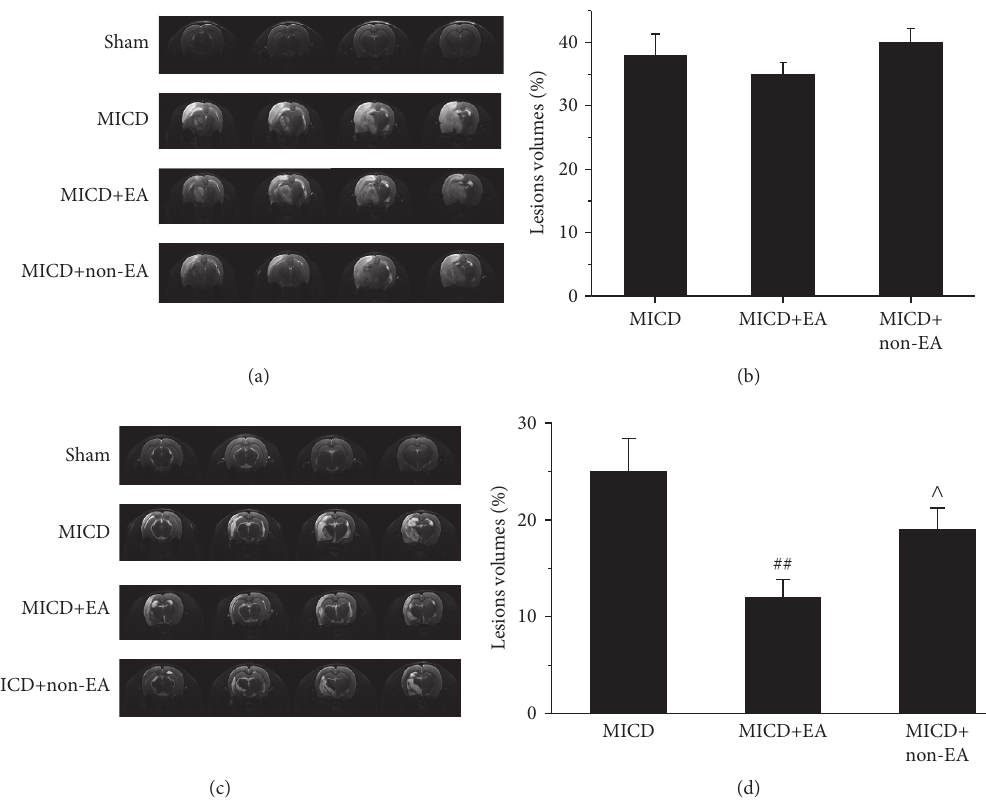
Figure3:T2WIsignalchangesbeforeandafterEA(aandc).ThebrainlesionsweremeasuredbyT2WI(slicesfrom11to13)intheShamgroup, the MICD group, the MICD+EA group, and the MICD+non-EA group before (a) and after (c) EA. (b and d) Lesion volume is represented as a percentage of the total brain volume and data are presented as the mean ± standard deviation from 12 individual rats in each group. ( ∗∗ 𝑝 < 0.01 versus the Sham group; ## 𝑝 < 0.01 , # 𝑝 < 0.05 versus the MICD group; ∧∧ 𝑝 < 0.01 , ∧ 𝑝 < 0.05 versus the MICD+EA group). T2WI: T2-weighted magnetic resonance imaging; MICD: middle cerebral artery occlusion induced cognitive